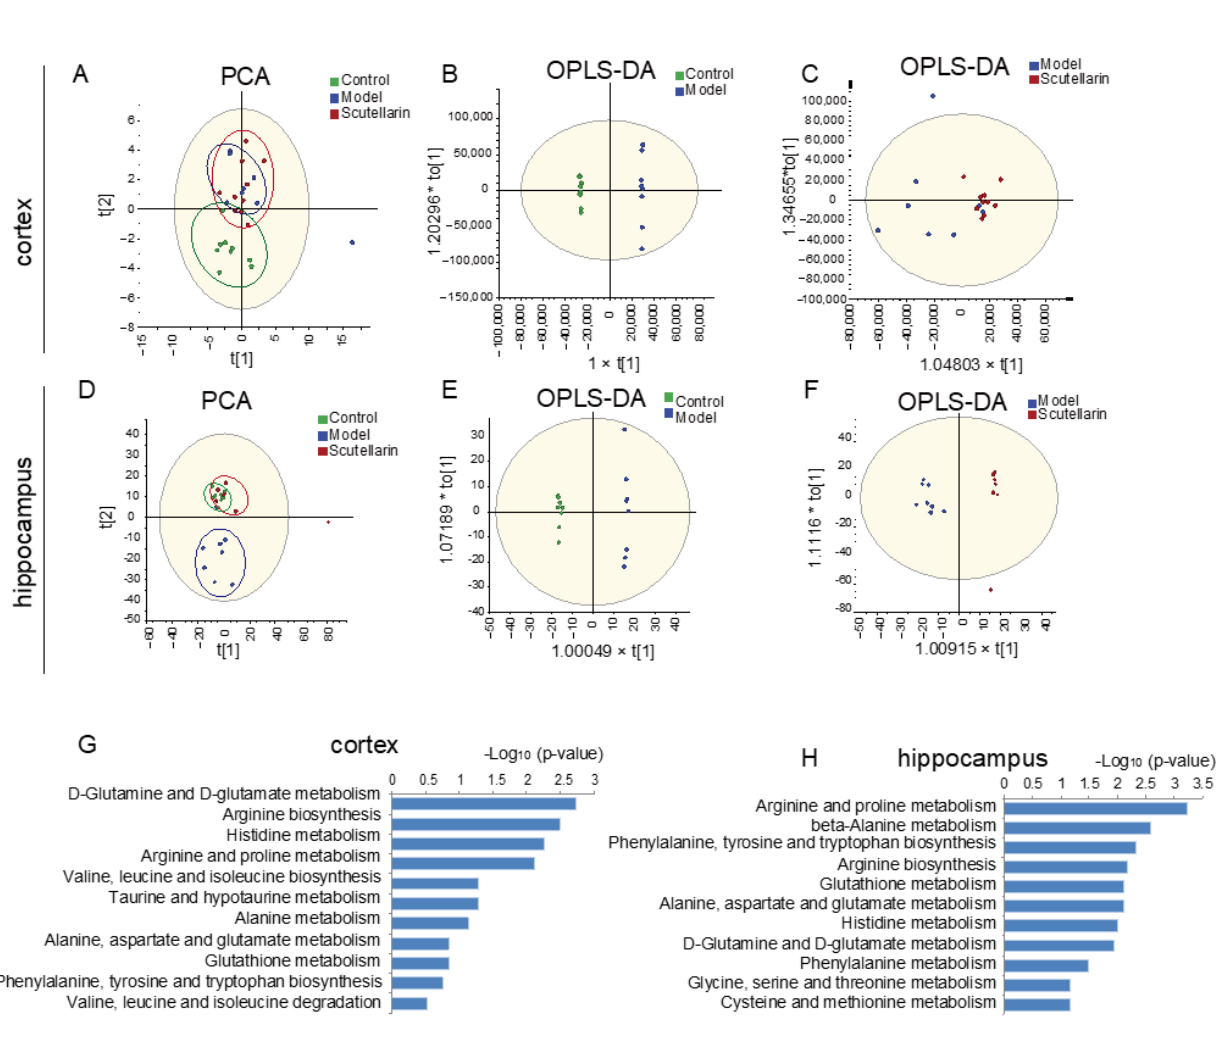
Figure 5. Scutellarin’s regulation of metabolic activities in the brains of MCAO/R model rats at 12 h after reperfusion. ( A , D ) The PCA results of metabolomics data show the redressing effect of scutellarin on the expression of aberrant metabolites in the cortex ( A ) and hippocampus ( D ), induced by MCAO/R modeling. ( B , C , E , F ) OPLS-DA on LC-MS data of common metabolites in cortex and hippocampus of control group, model group, and scutellarin group. ( B ) Control vs. model groups for cortex. ( C ) Control vs. scutellarin groups for cortex. ( E ) Control vs. model groups for hippocampus. ( F ) Control vs. scutellarin groups for hippocampus. ( G , H ) The KEGG metabolic pathway enrichment results for cortex metabolomics ( G ) and hippocampus metabolomics ( H